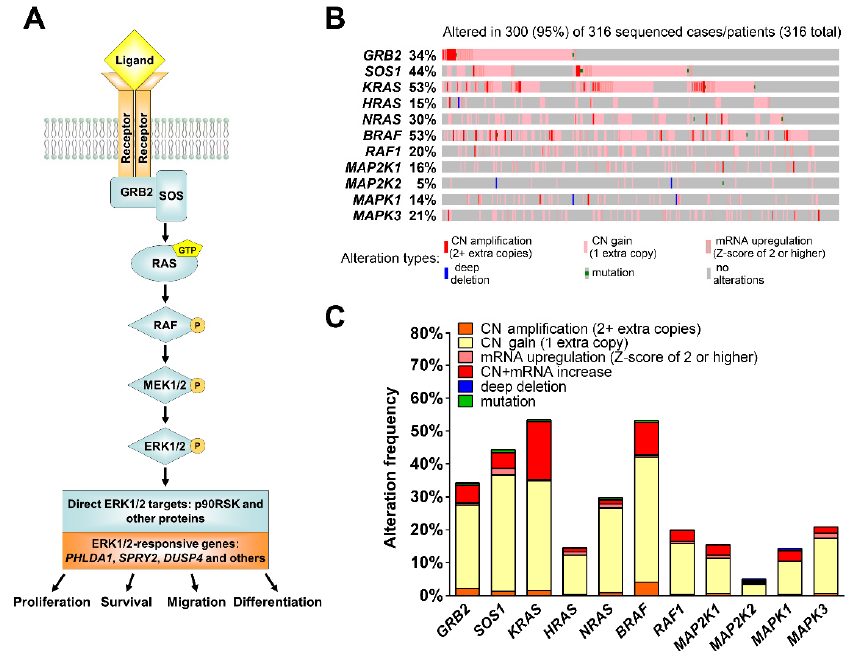
Figure 1. The MEK1/2 signaling pathway and its genetic alterations observed in HGSOC tissues. ( A ) The main elements of the MEK1/2 signaling pathway and cell properties controlled by its